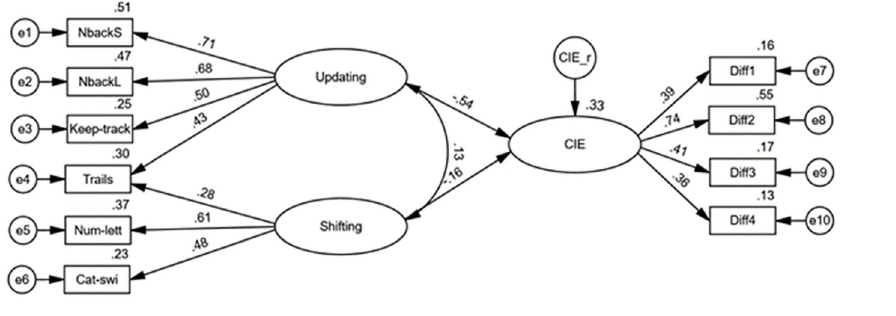
Fig 3. Structural equation model of multiple regression between EF-subcomponent latent variables and CIE latent variable. Note. Straight lines with single arrows are regression paths. The observed variables on the left represent EF-task scores. The observed variables on the right represent CIE scores. Numbers on top-right of observed variables and CIE latent variable represent proportion of variance accounted for in each variable. Error terms associated with each observed variable are indicated by e1-10. Factor loadings and correlations are fully standardised.